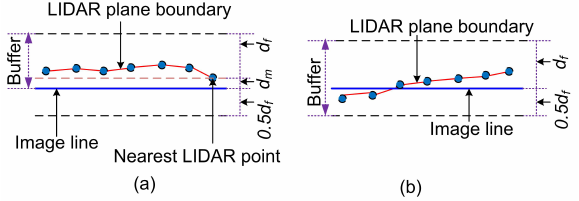
Figure 7: Fitting LIDAR plane boundary to an image. The line is: (a) completely inside or outside of the boundary and (b) inter- sected with the